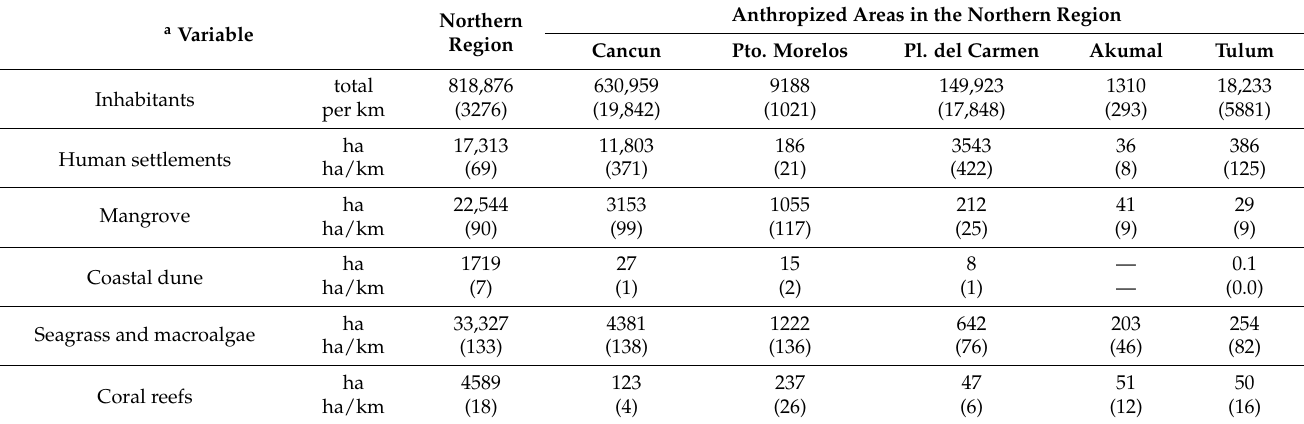
Table 3. Characteristics of land use in the northern Mexican